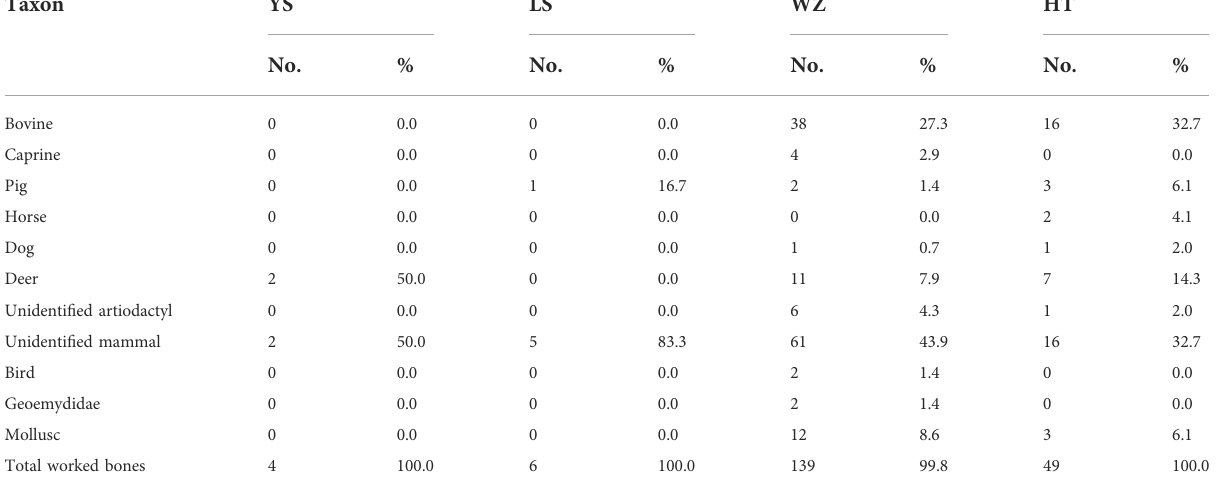
TABLE 4 Animal taxa for worked bones from Xitou.